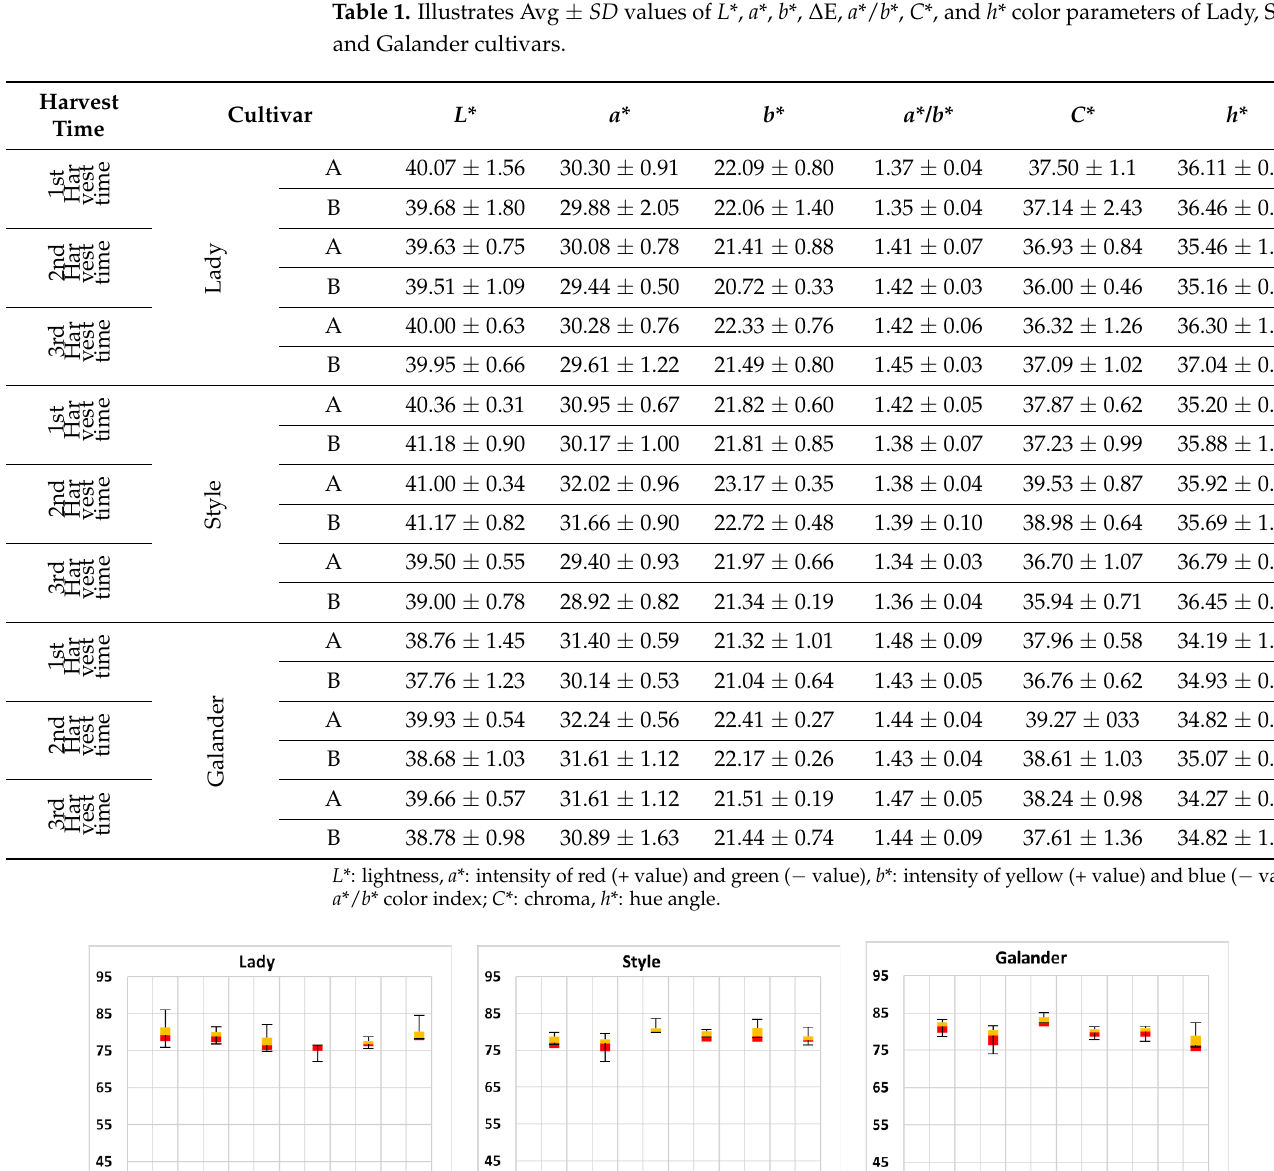
Table 1. Illustrates Avg ± SD values of L *, a *, b *, ∆ E, a */ b *, C *, and h * color parameters of Lady, Style, and Galander cultivars.